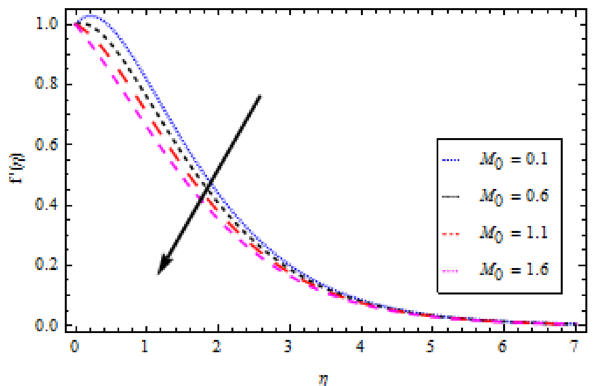
Figure 4. Velocity profile variation with respect to M 0 .